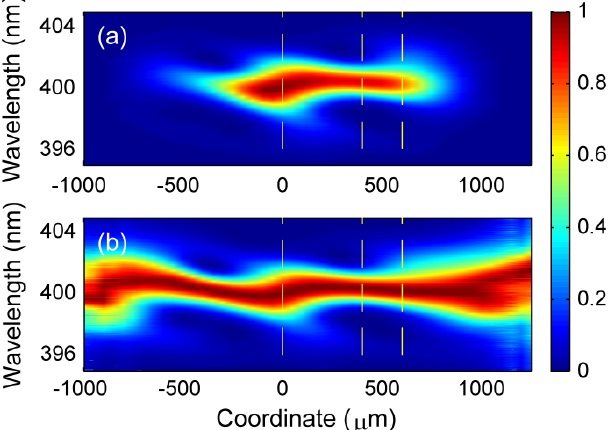
Figure 11. Variation of autocorrelation beam spectra on the NPC position. ( a ) Net data; ( b ) Data normalized to the maximal value in every section of constant